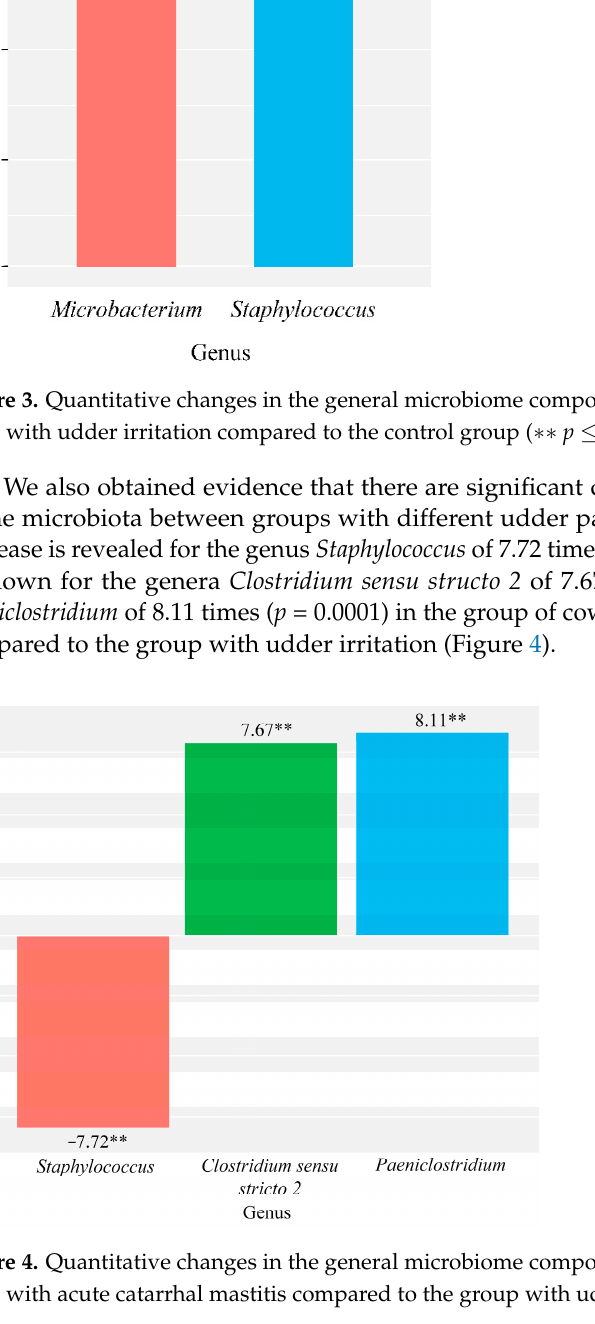
Figure 2. Quantitative changes in the general composition of the microbiome of milk samples taken from cows with acute catarrhal mastitis, compared to the control group ( ∗ p ≤ 0.01, ∗∗ p ≤ 0.001).